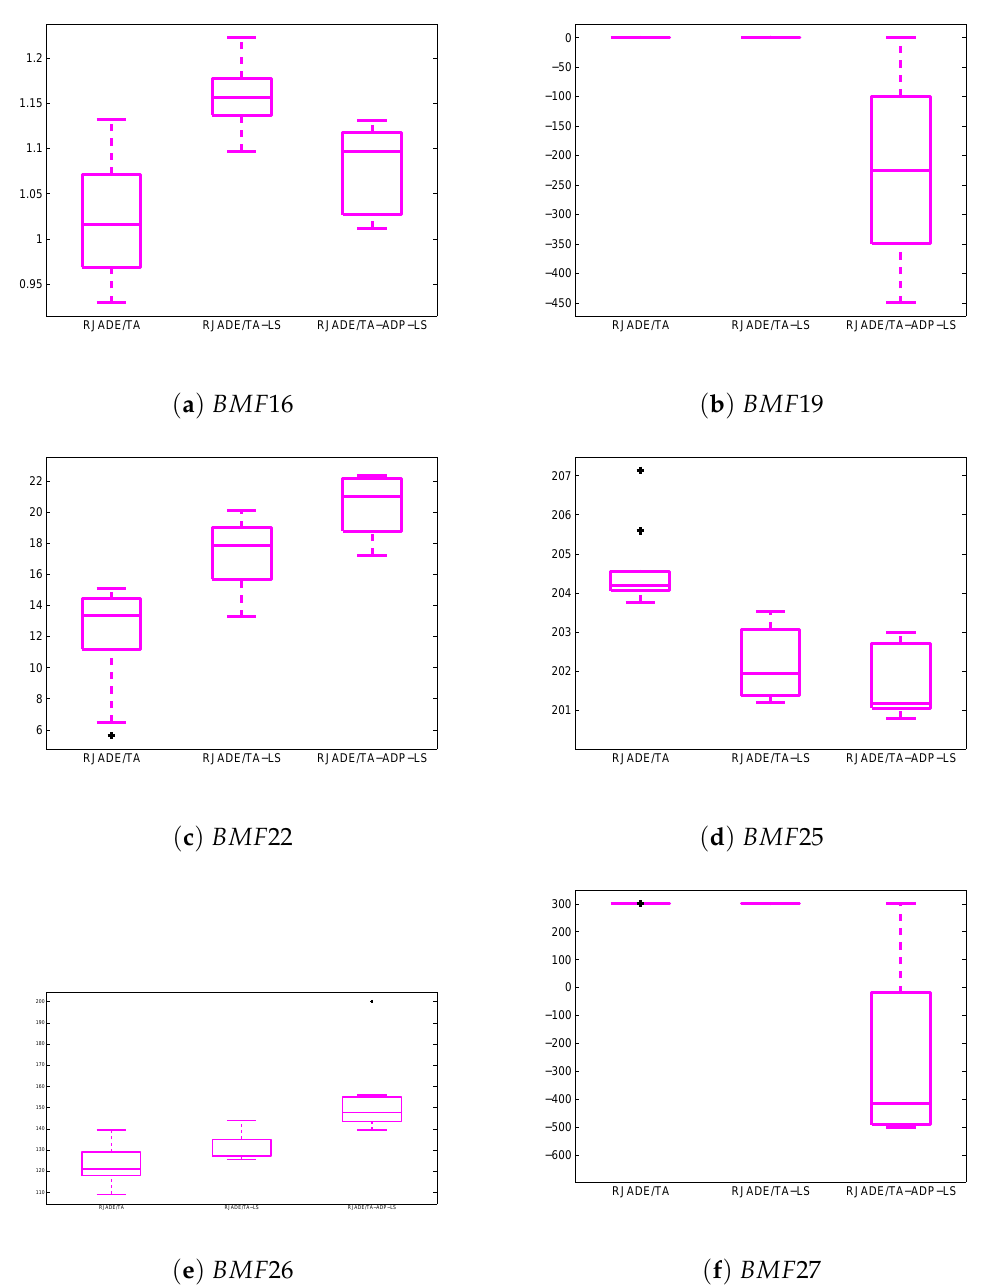
Figure 3. Box plots of various algorithms in